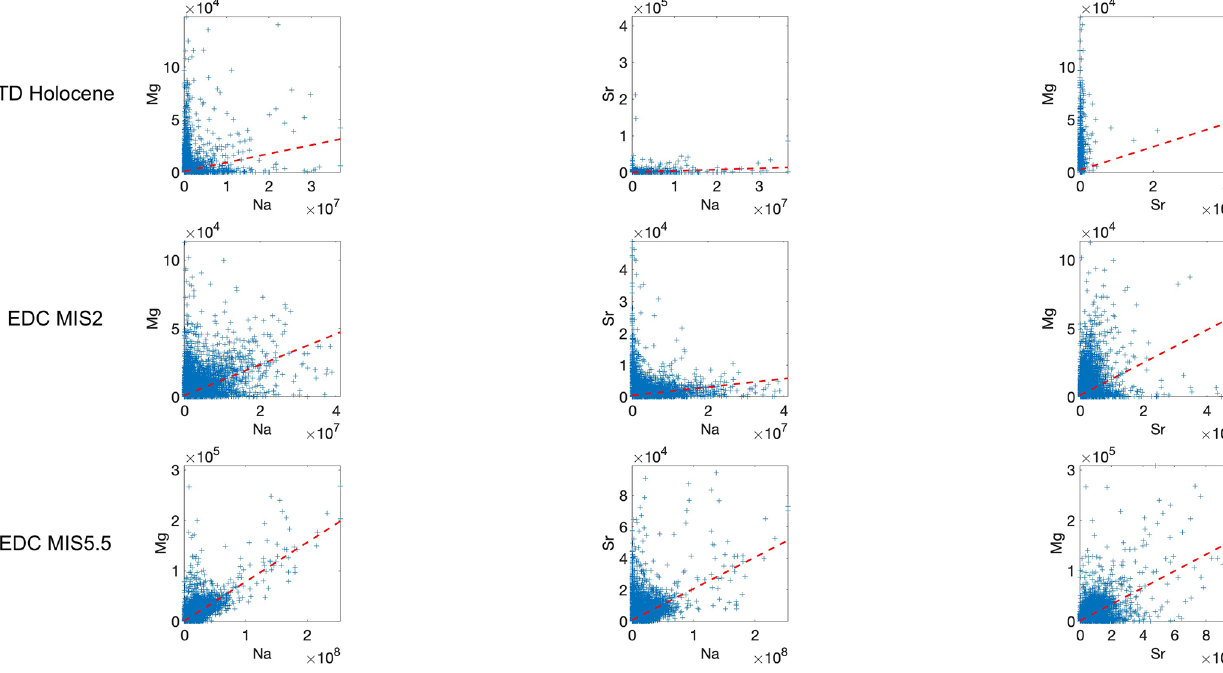
Figure 5. Scatterplots compiled from the matrices of intensity values (counts) underlying the images shown in Figs. 2, 3 and 4. A linear regression (red dashed line) is shown purely as a visual